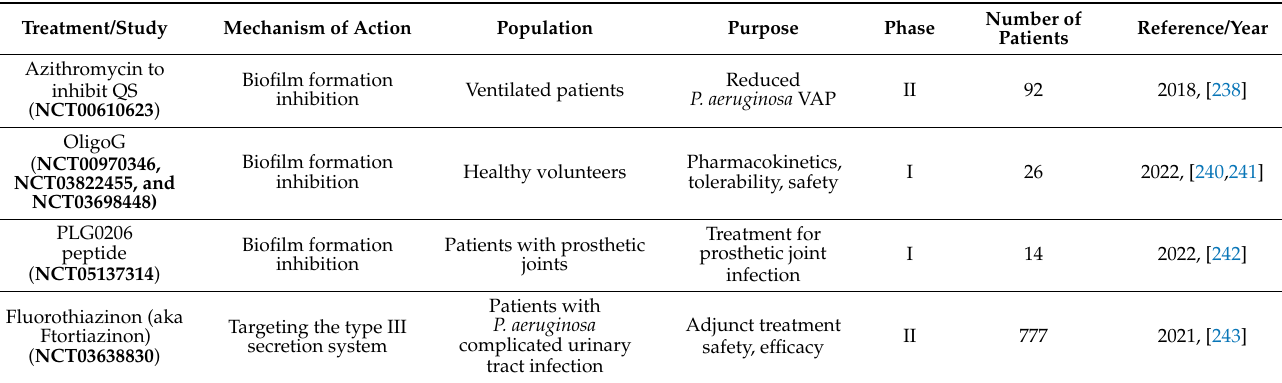
Table 3. Strategies targeting P. aeruginosa